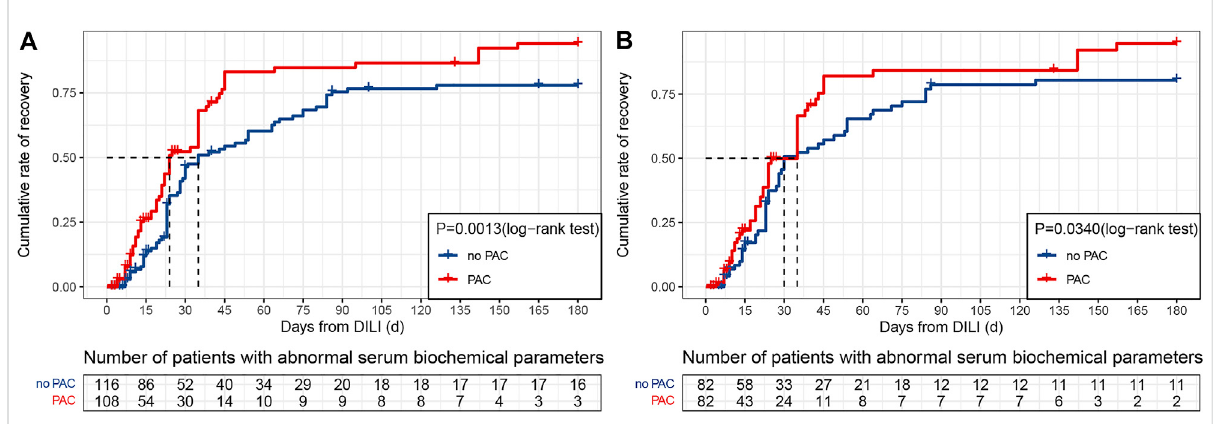
FIGURE 3 Kaplan – Meiercumulativeeventratesfortimetorecovery. (A) Originalcohort. (B) PSMcohort.Abbreviations:DILI,drug-inducedliverinjuryand PAC, pharmacist active